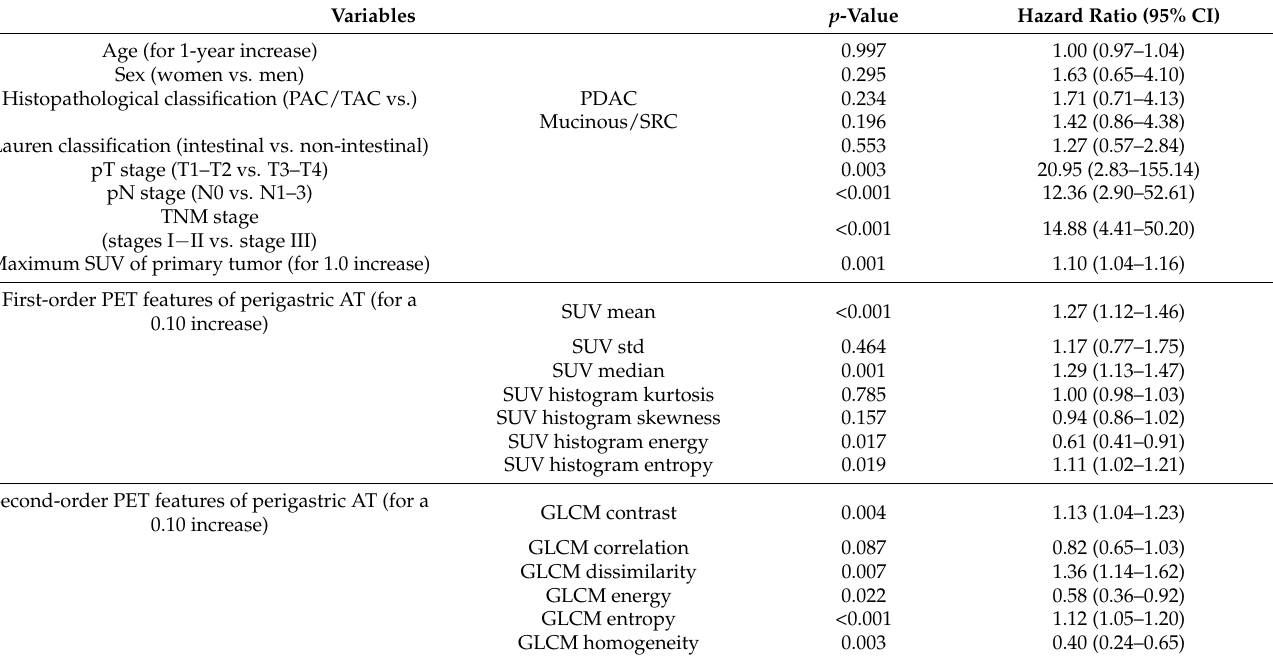
Table 3. Results of univariate analysis for recurrence-free survival. Variables